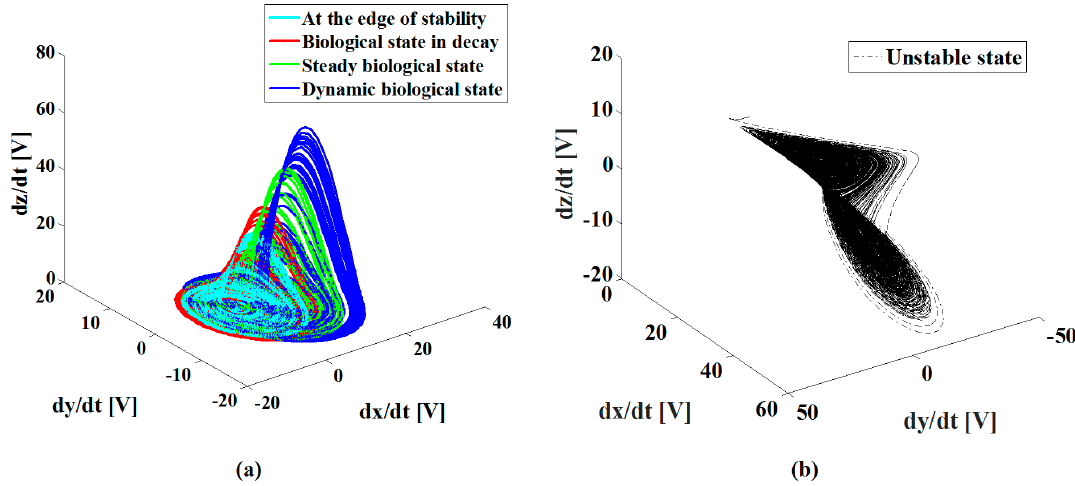
Figure 9. ( a ) Evolution of the steady-state Rössler attractors obtained in the Au NPs incorporated into cells; ( b ) Measurement obtained in dead cells.